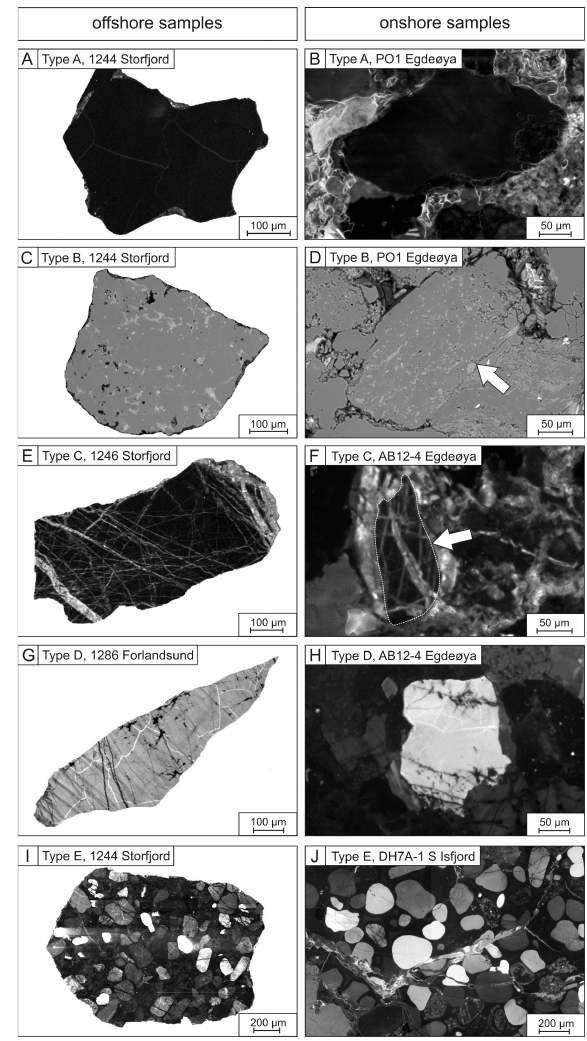
Fig. 11. SEM-CL and BSE images of quartz comparing grain types in offshore (left column) and onshore samples (right column). (A) SEM-CL image of a dull luminescent, featureless type A grain with sericitic remains at the grain edge (brighter areas). (B) SEM-CL image of a dull luminescent, featureless quartz grain of type A in Late Triassic sandstone from Edgeøya. (C) BSE image of a type B quartz grain with common mica and feldspar inclusions. (D) BSE image of a type B quartz grain (arrow) with common mica and feldspar inclusions in Late Triassic sandstone form the Edgeøya. (E) SEM-CL image of a type C grain from offshore sample 1246. (F) SEM-CL image showing a type C grain (arrow) in Late Trias- sic sandstone from the Edgeøya. (G) SEM-CL image of a bright luminescent type D grain from offshore sample 1286. (H) SEM-CL image of a bright luminescent type D grain in Late Triassic sand- stone from the Edgeøya. (I) SEM-CL image of an arkose fragment (type E) from offshore sample 1244. (J) SEM-CL image of a large arkose fragment (type E) in Early Cretaceous sandstone from the southern Isfjord